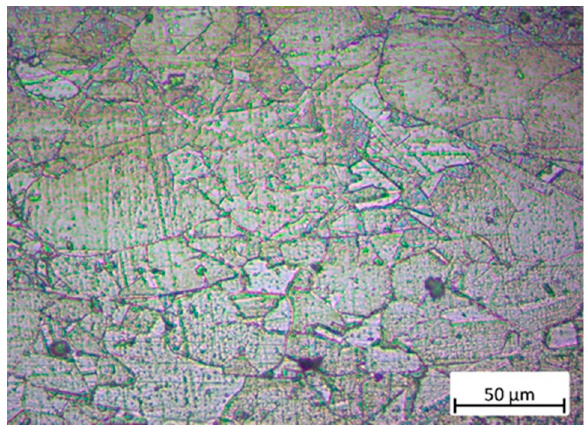
Figure 4. Cross ‐ sectional optical micrograph of the original GH3039 superalloy sample. Figure 4. Cross-sectional optical micrograph of the original GH3039 superalloy